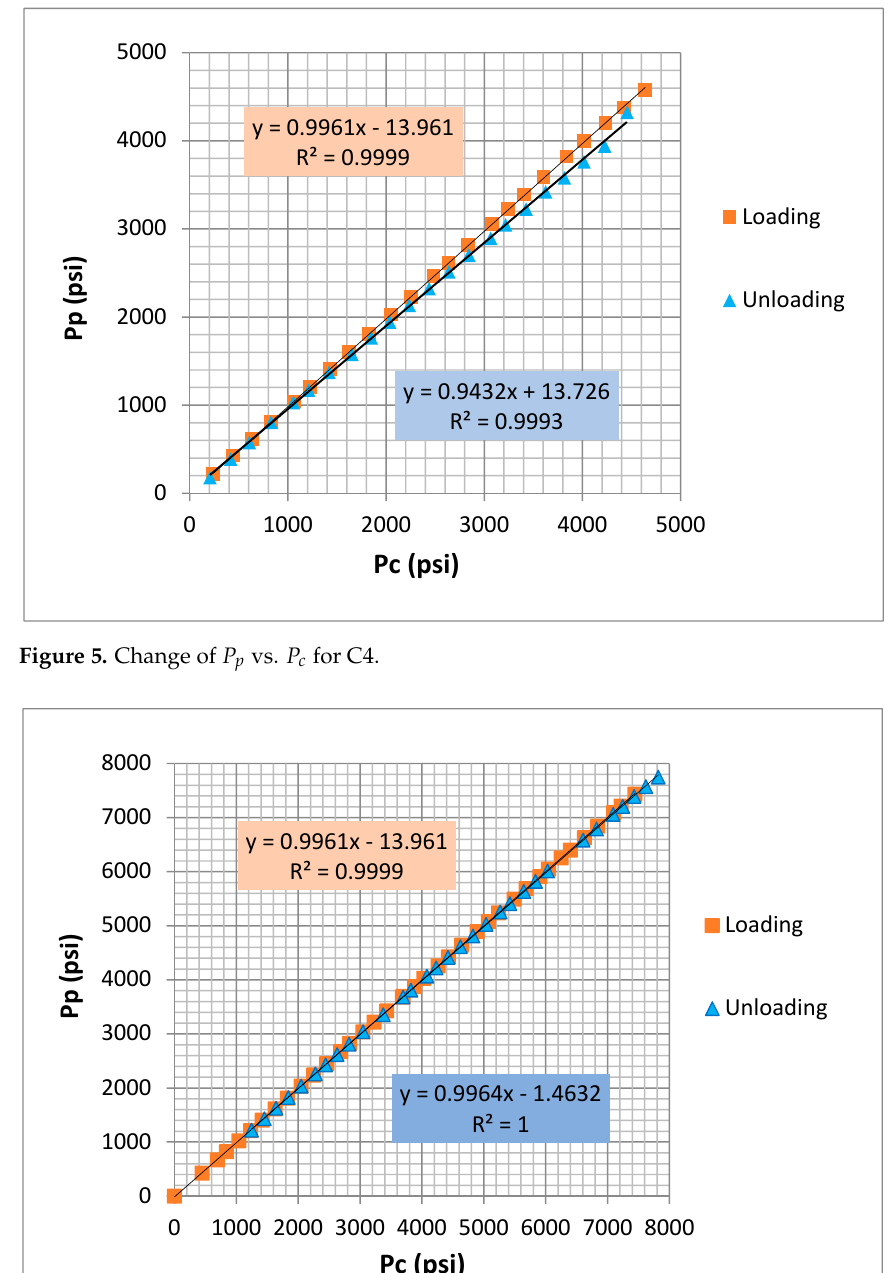
Figure 6. Change of 𝑃 (cid:3043) vs. 𝑃 (cid:3030) for C5.